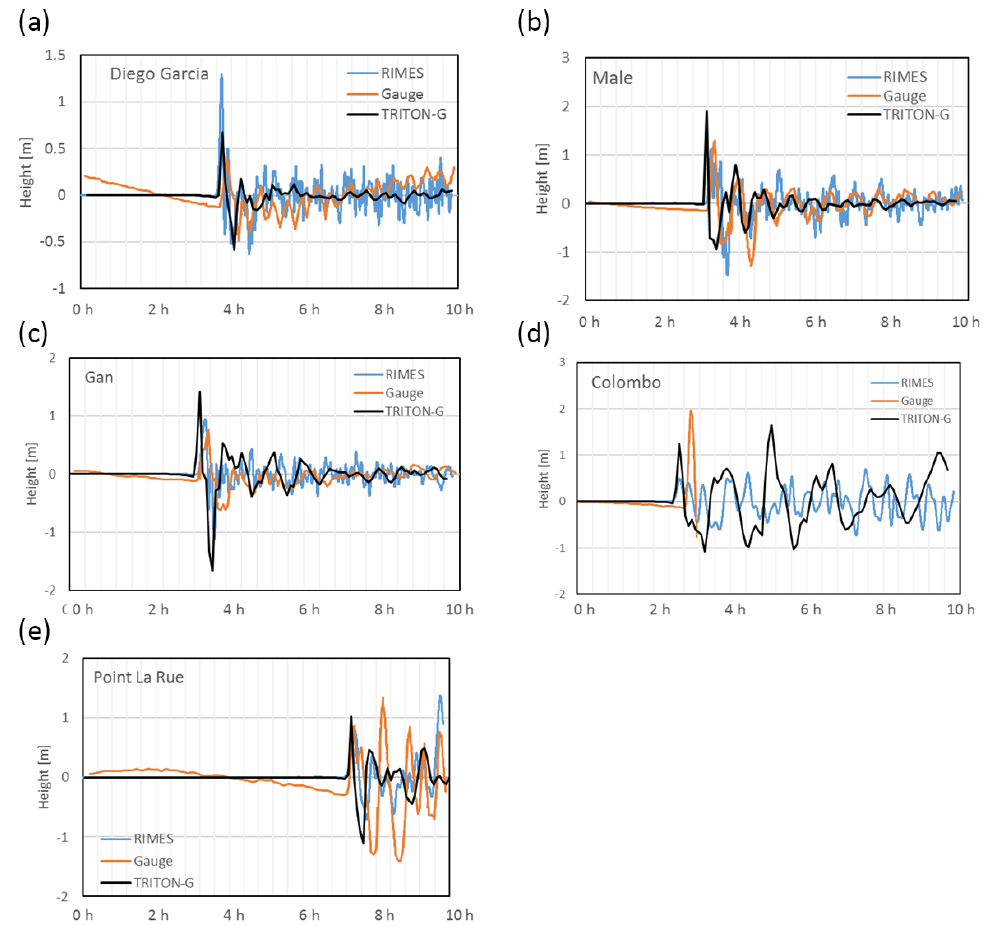
Figure 27. (a) Comparison of arrival wave at Diego Garcia, tide gauge and model results. (b) Comparison of arrival wave at Male, tide gauge and model results. (c) Comparison of arrival wave at Gan, tide gauge and model results. (d) Comparison of arrival wave at Colombo, tide gauge and model results. (e) Comparison of arrival wave at Point La Rue, tide gauge and model